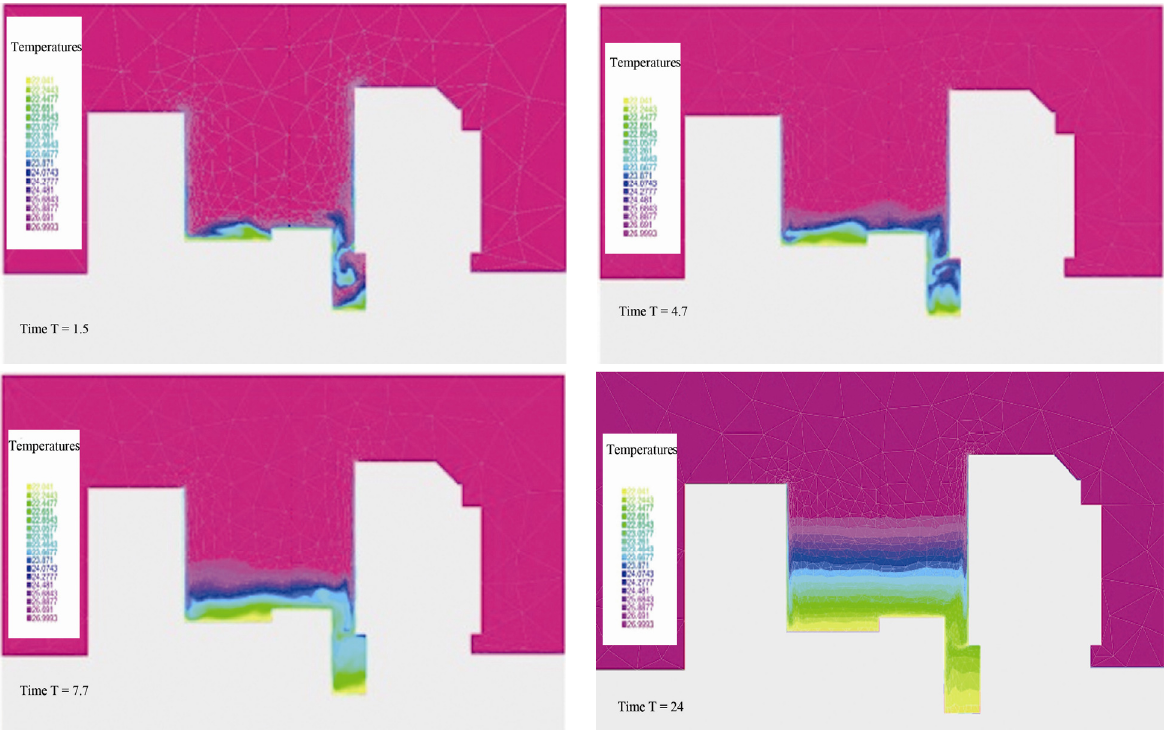
Figure 17. Test 1. Stratification of the air in the courtyard by buoyancy effects. Temperature: °C; T: